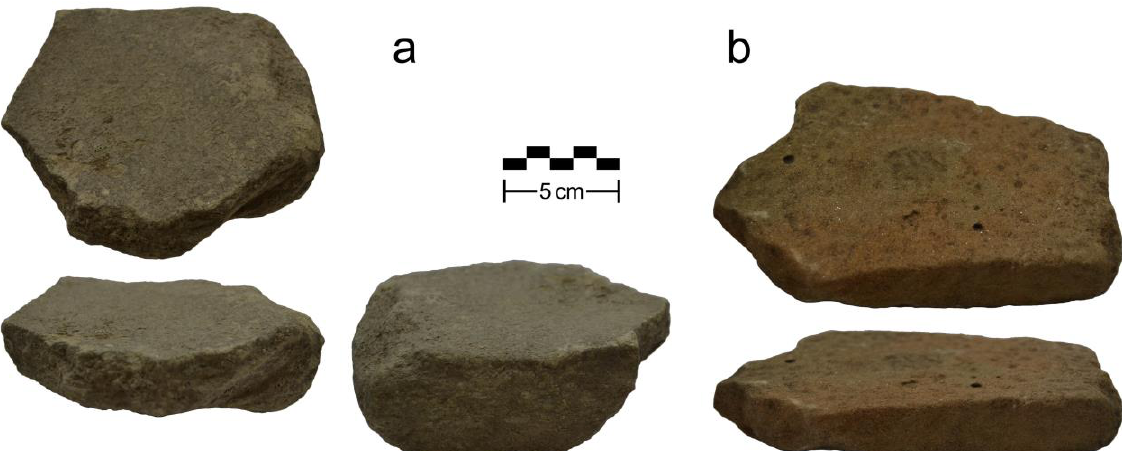
Figure 5. Examples of possible grinding slabs from Măgura ‘Buduiasca’. Mortars and